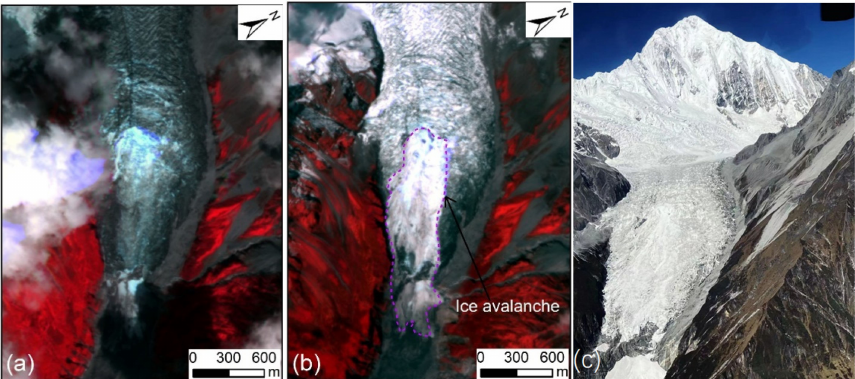
Figure 15. Ice avalanche identified using Planet optical satellite images taken on ( a ) 21 August 2022 and ( b ) 1 October 2022, and ( c ) an aerial photo taken on 20 October